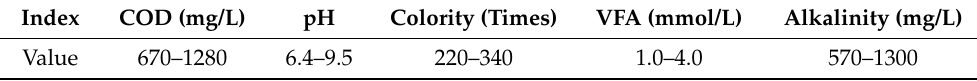
Table 1. Quality of the wastewater entering the anaerobic reactor.